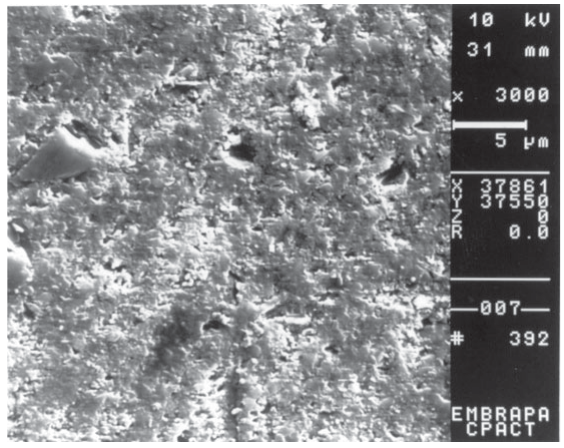
Figure 2. SEM micrography of Alert surface after 90 days of ag- ing (SEM original magnification 10000 × ).